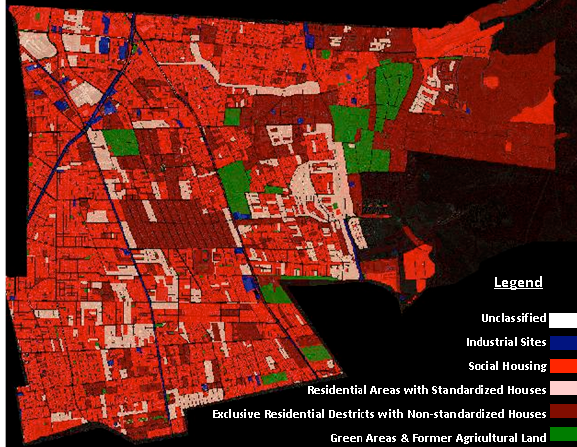
Figure 7. Municipal urban land use structure in the